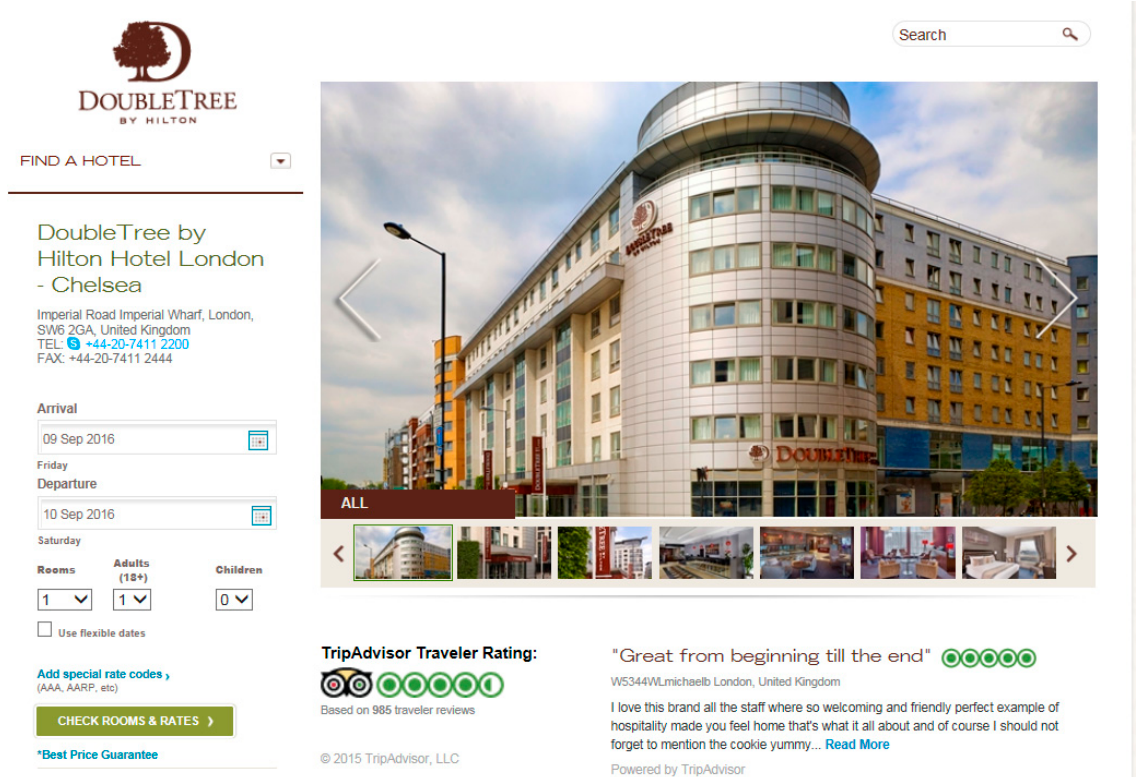
Figure A1. The rating is explicitly published on the website.